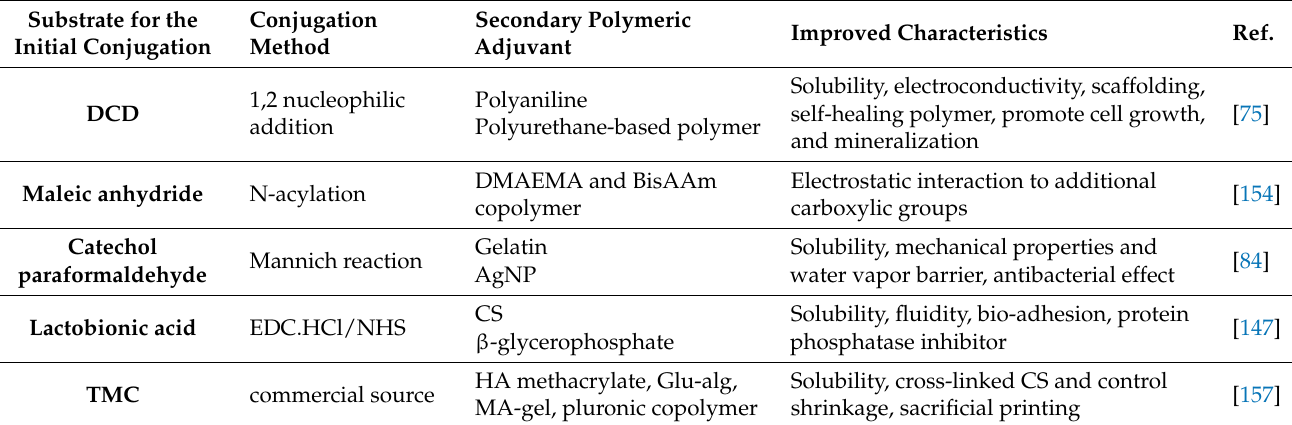
Table 3. Selected examples of CS-based materials involving polymeric